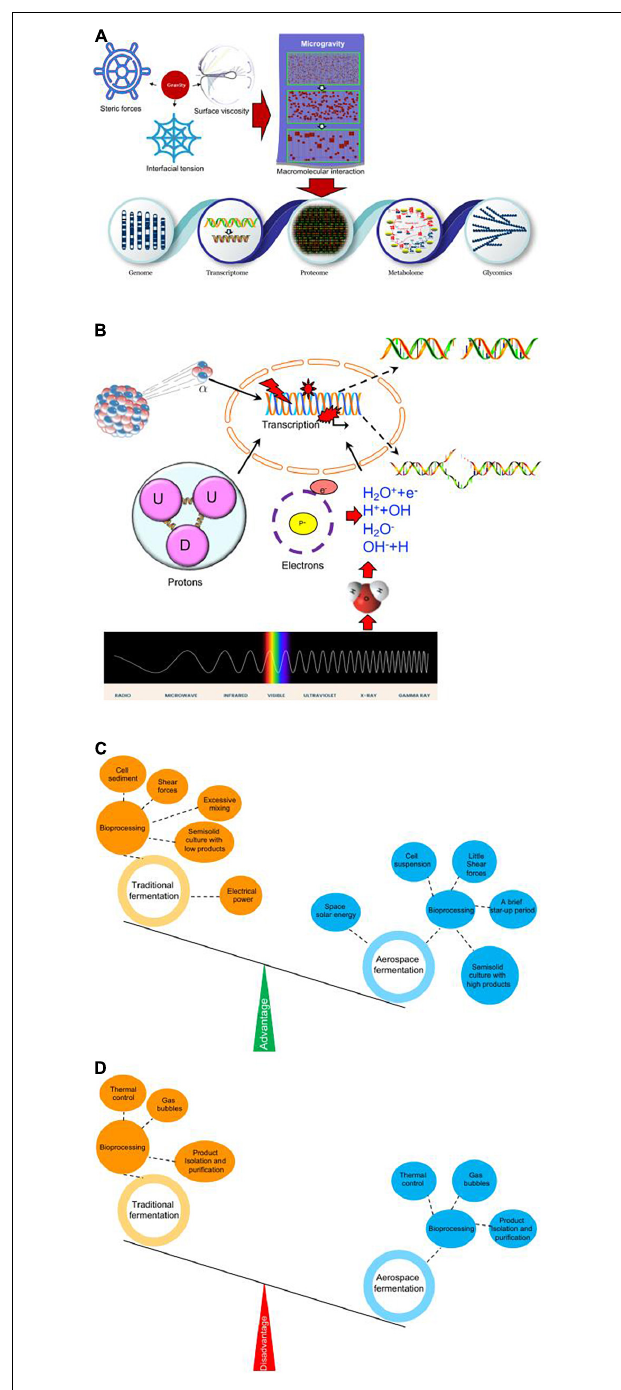
FIGURE 2 | Possible functional mechanisms for space microbiology technology. (A) Possible physical and molecular mechanisms for space microgravity-inducing mutant microorganisms. (B) Physical, chemical, and biological effects of space radiation. X-ray and alpha-particles induce DNA double-strand break and UV irradiation and gamma irradiation induce DNA single-strand breaks. (C) Advantages of space fermentation technology when compared with terrestrial fermentation technology. (D) Disadvantages of space fermentation technology when compared with terrestrial fermentation